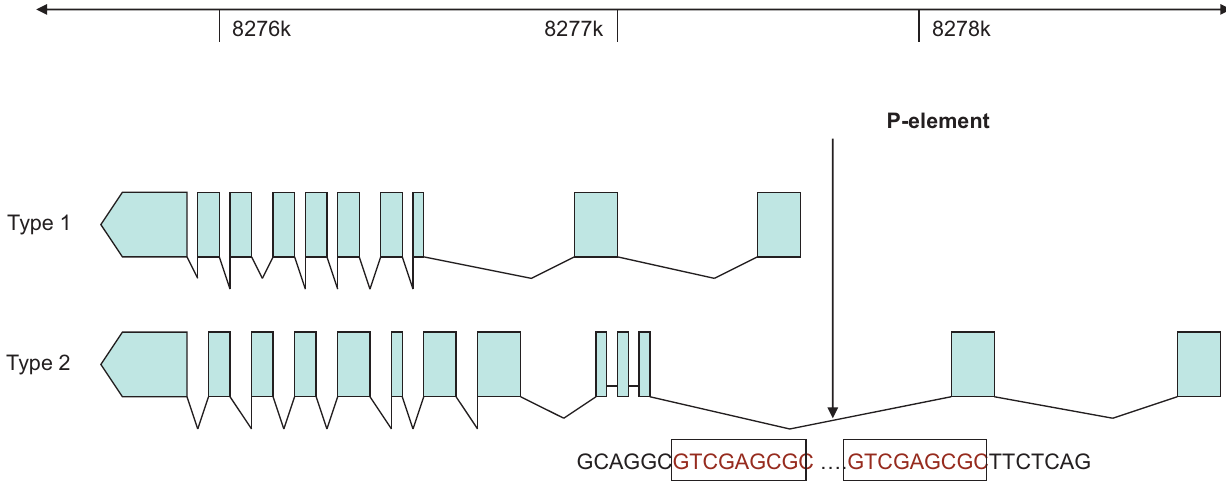
Figure 1. P-element insertion point detection: Schematic figure showing P-element transposon P(Bm D -w) insertion site. Sequencing results shows P-element insertion site (arrow) within the genomic DNA of Btk29A at 2L: 8277721. GTCGAGCGC repeats can be seen at both end of the P insertion, which is a characteristic mark of transposon insertion. This information was further use to distinguish between mutant and revertant flies. In mutant flies this breakpoint was easily detected in amplicons (Materials and Methods), whereas the revertant did not show any P